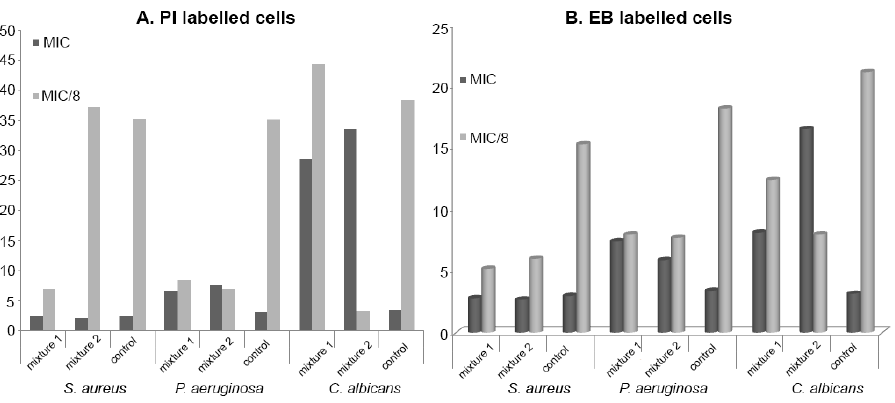
Figure 5. MFI for the analytical variants tested on the specified strains. ( A ) PI labeles cells; ( B ) EB labeled cells.